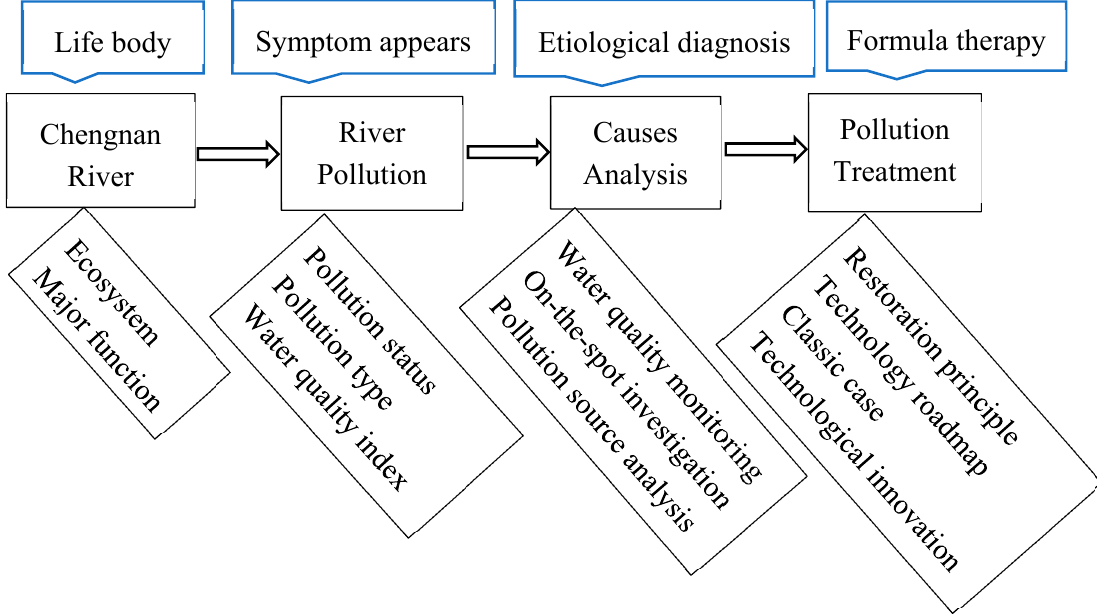
Figure 2. Integrated management ideas in combination with traditional Chinese Medicine.